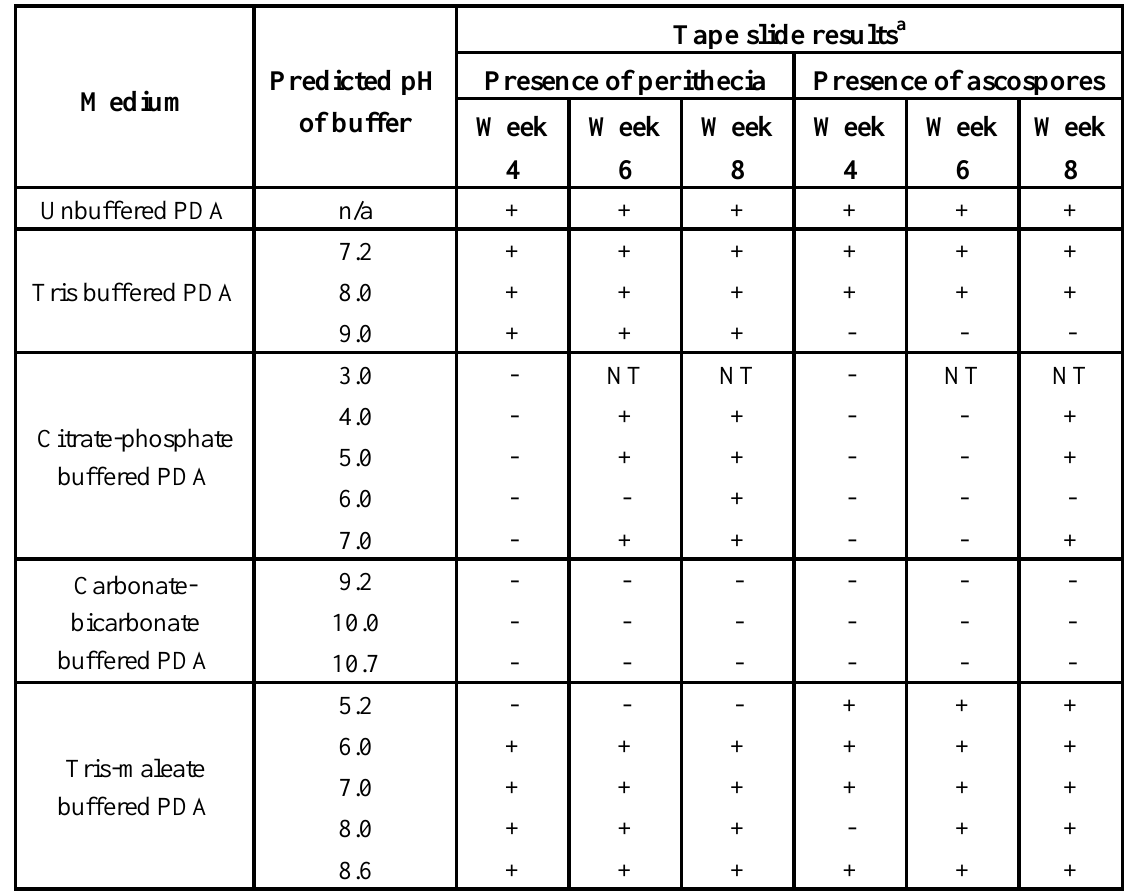
Table 2. Effect of pH on the